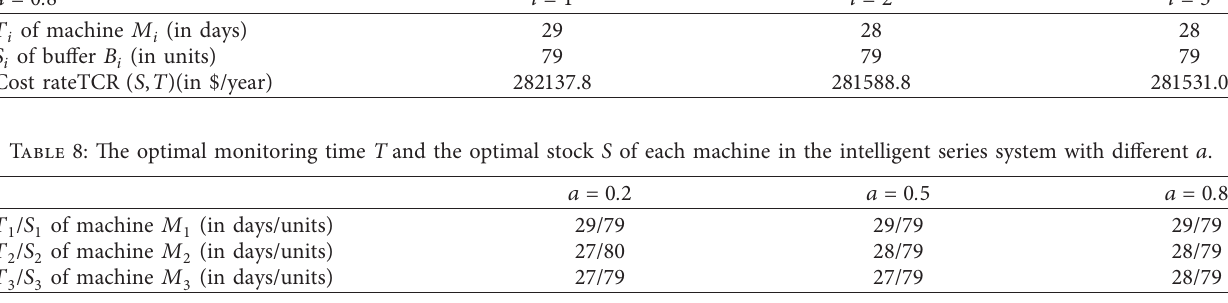
Table 6: Failure rate of virtual machine M